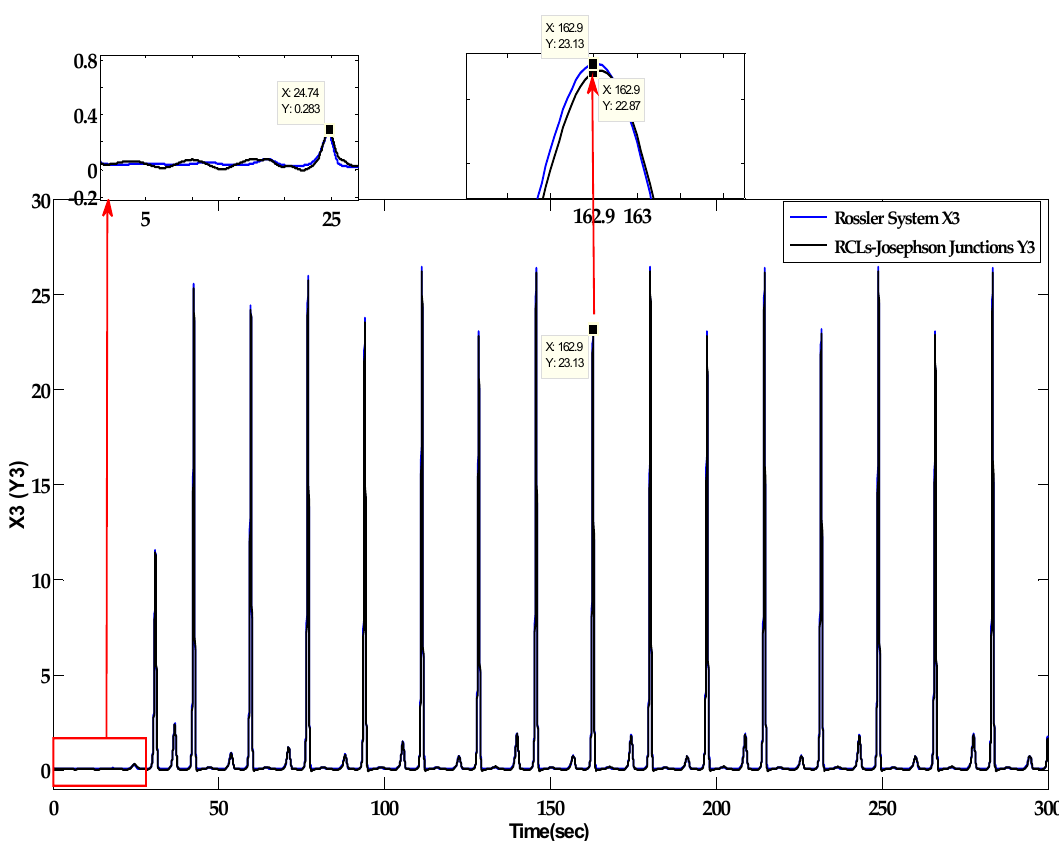
Figure 7. The time response of x 3 for the Rossler system and y 3 for RCLs-JJ using the ILC (iterative learning control) update rule.